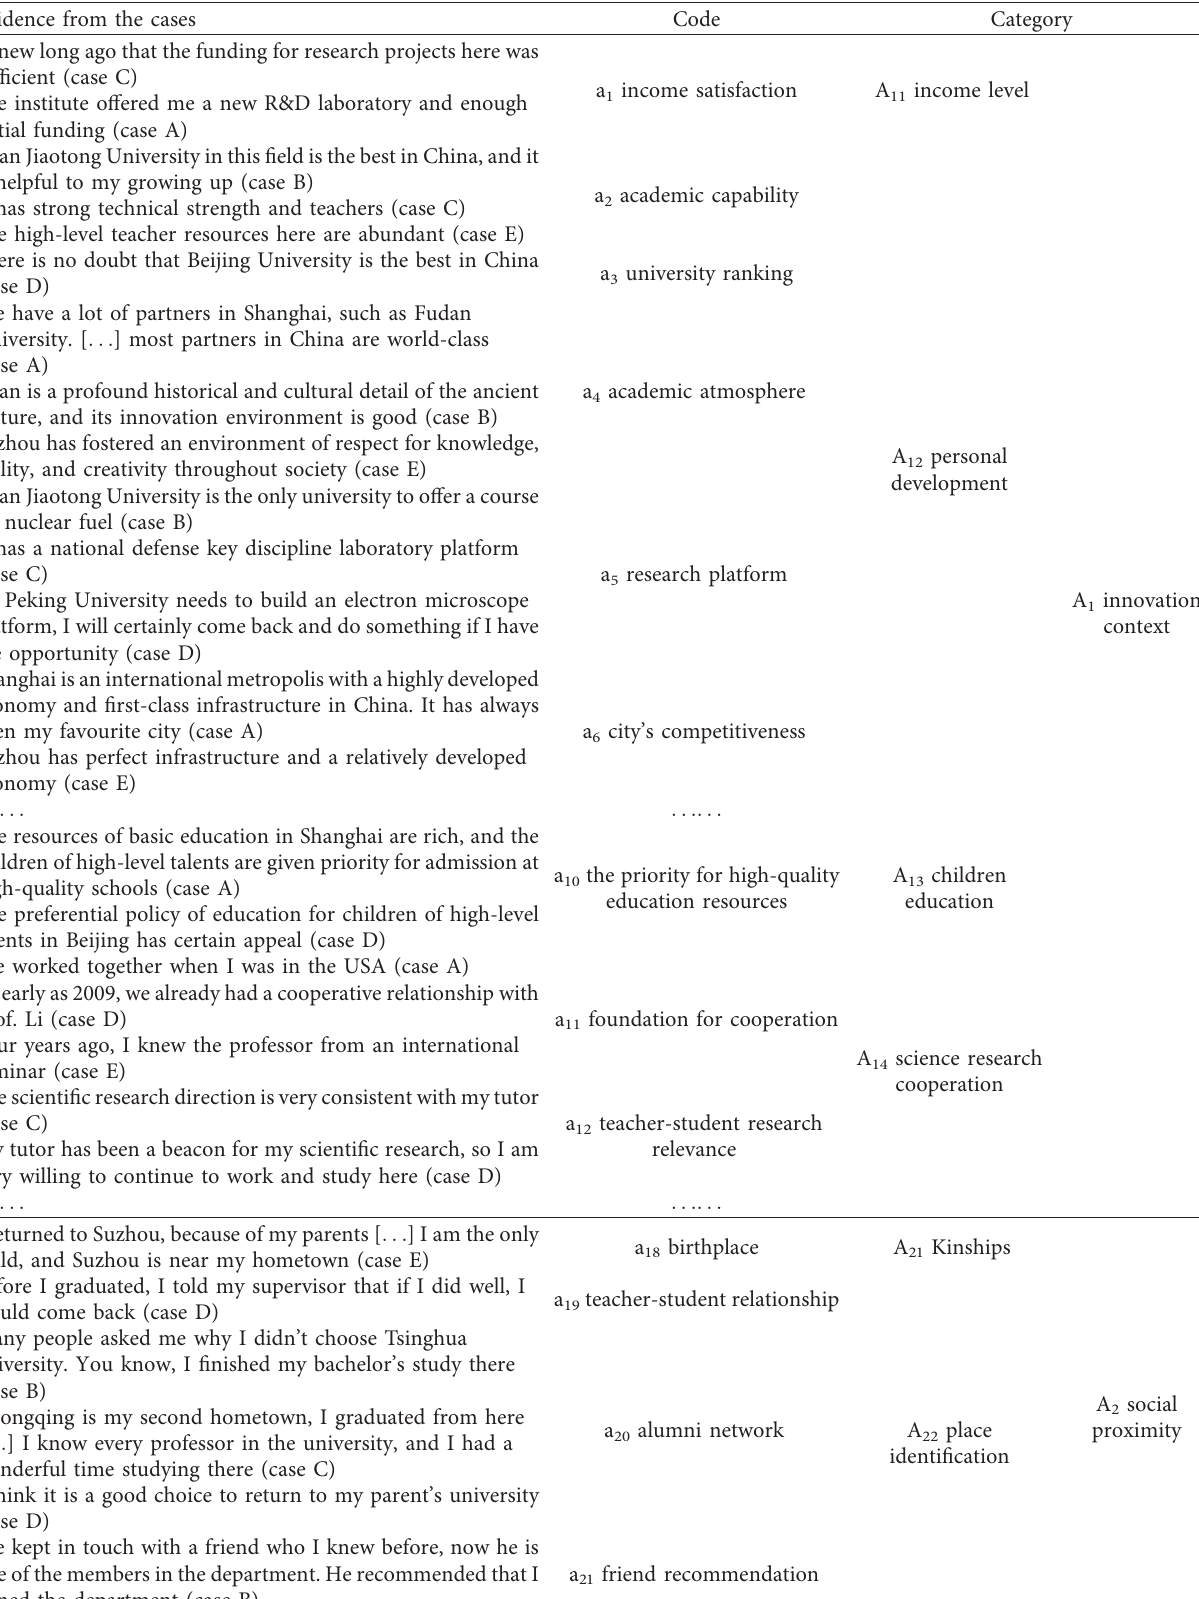
Table 5: The process of coding